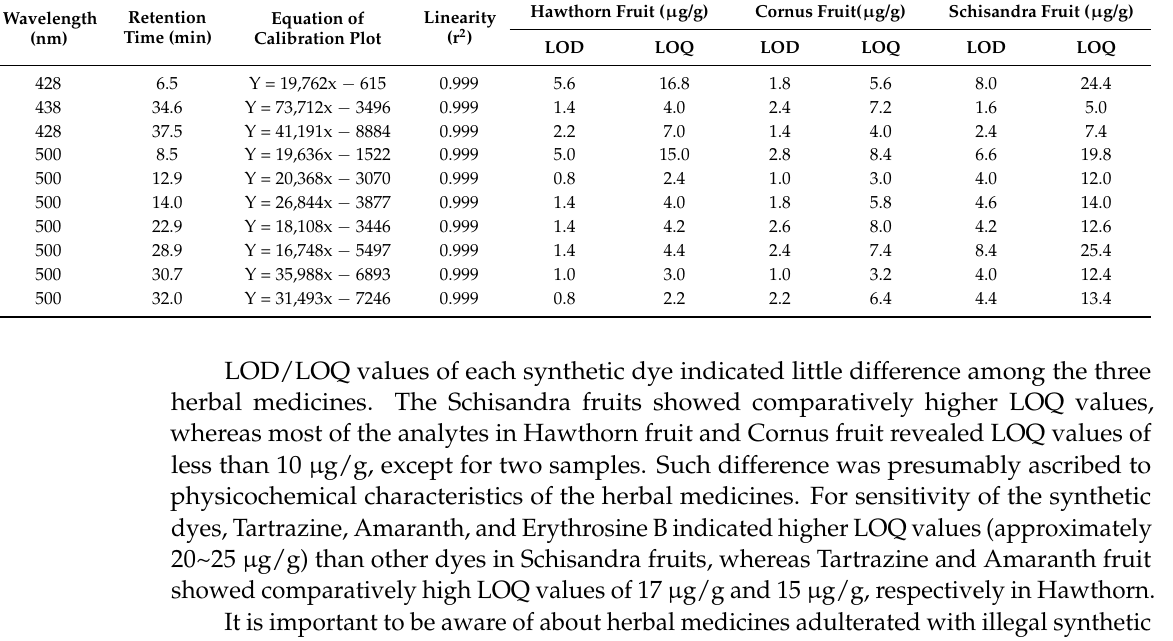
Table 2. The values of LOD, LOQ, and linearity obtained from the HPLC-PDA analysis method.